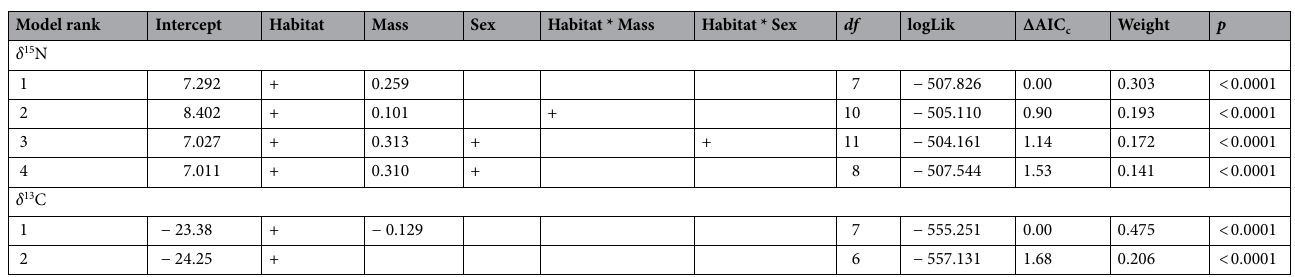
Table 1. Summary of linear mixed models where ΔAIC c < 2 for δ 15 N and δ 13 C values (‰). Habitat, sex, and mass (as a proxy for body size) were included as fixed variables, and animal ID as a random variable. p values are compared to the null model. All tested models are listed in Supplementary Tables 3 ( δ 15 N) and 4 ( δ 13